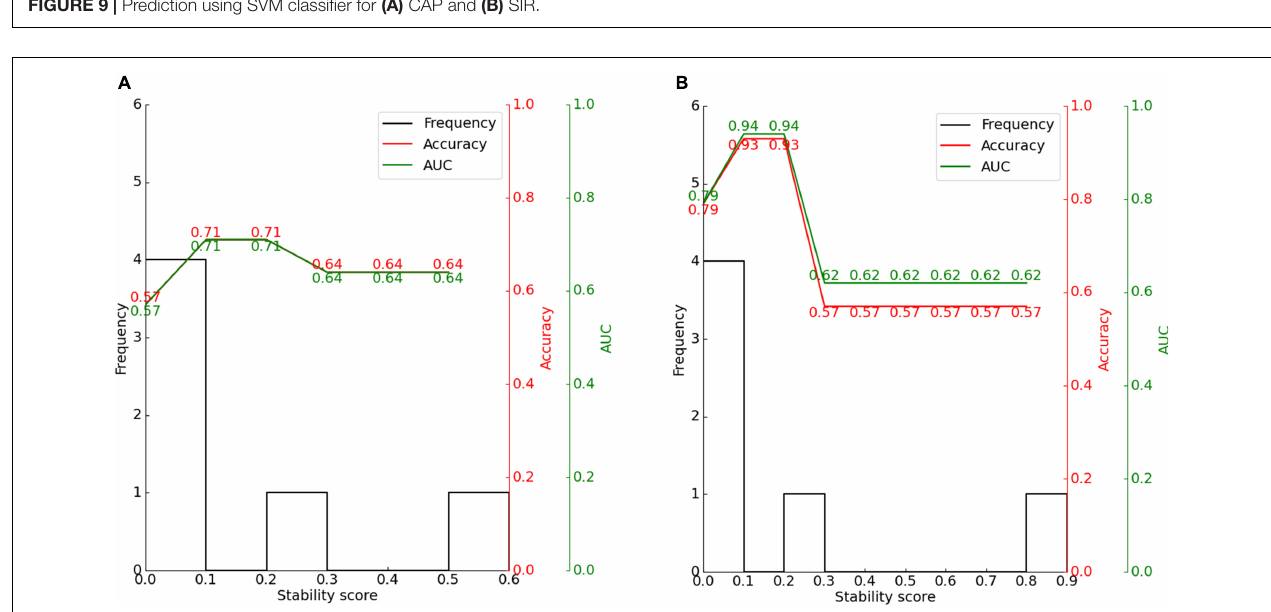
FIGURE 10 | Effect of stability score threshold on model performance for (A) CAP and (B) SIR. The stability score ranges from 0 to